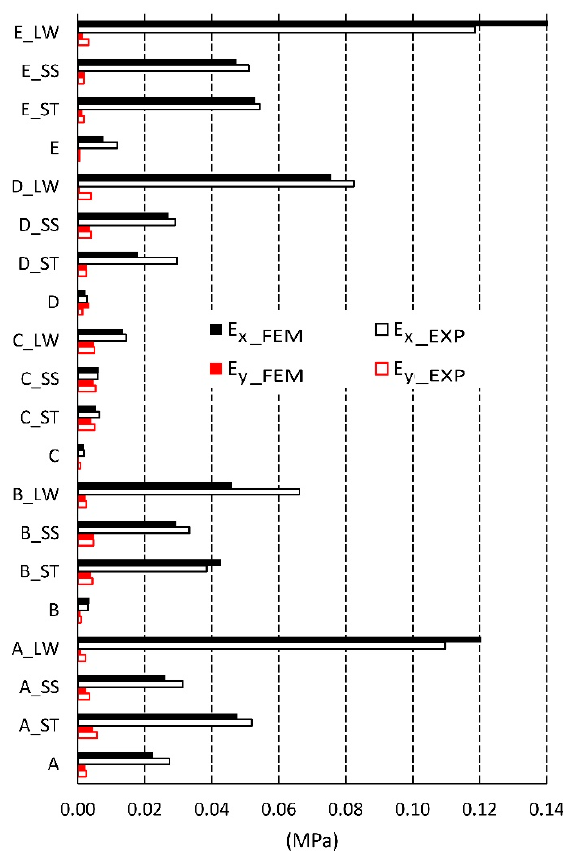
Figure 13. Modulus of linear elasticity for cells of the type: A, B, C, D, E (EXP-experimental research, FEM-numerical calculations).